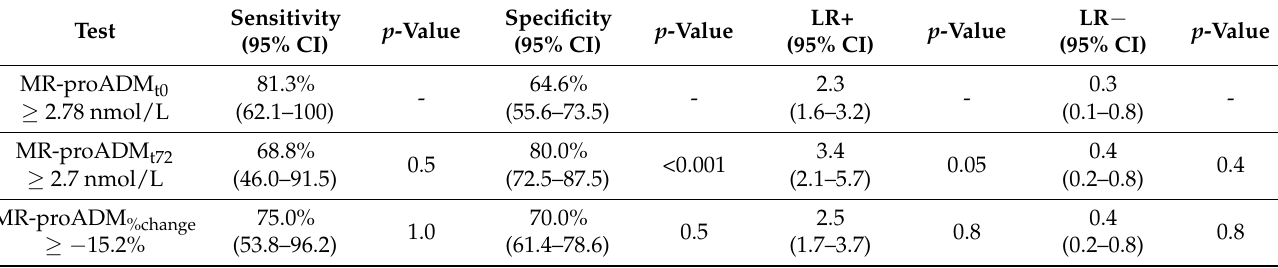
Table 2. Prognostic performance measures.